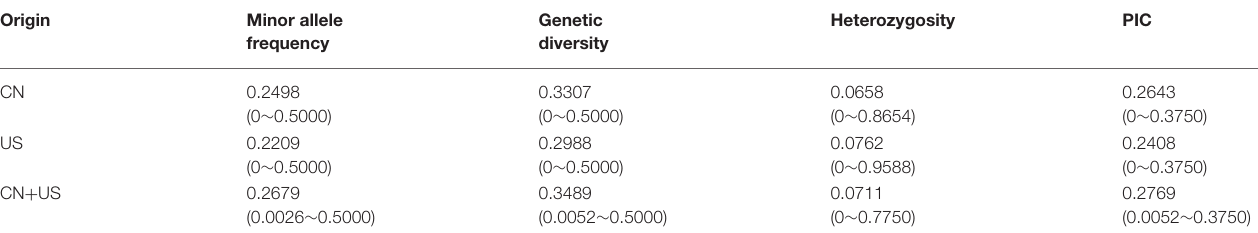
TABLE 1 | Genetic parameters revealed by the analysis of 5,195 polymorphic SNP markers among the soybean accessions of the diversity panel.